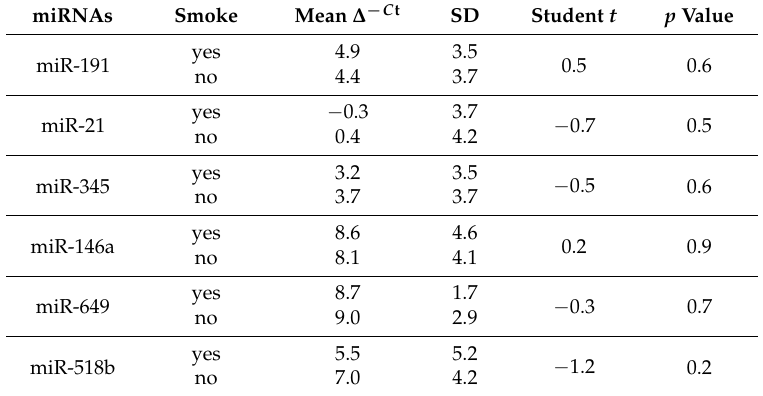
Table 1. Comparison of expression levels of selected miRNAs between smokers and nonsmokers.